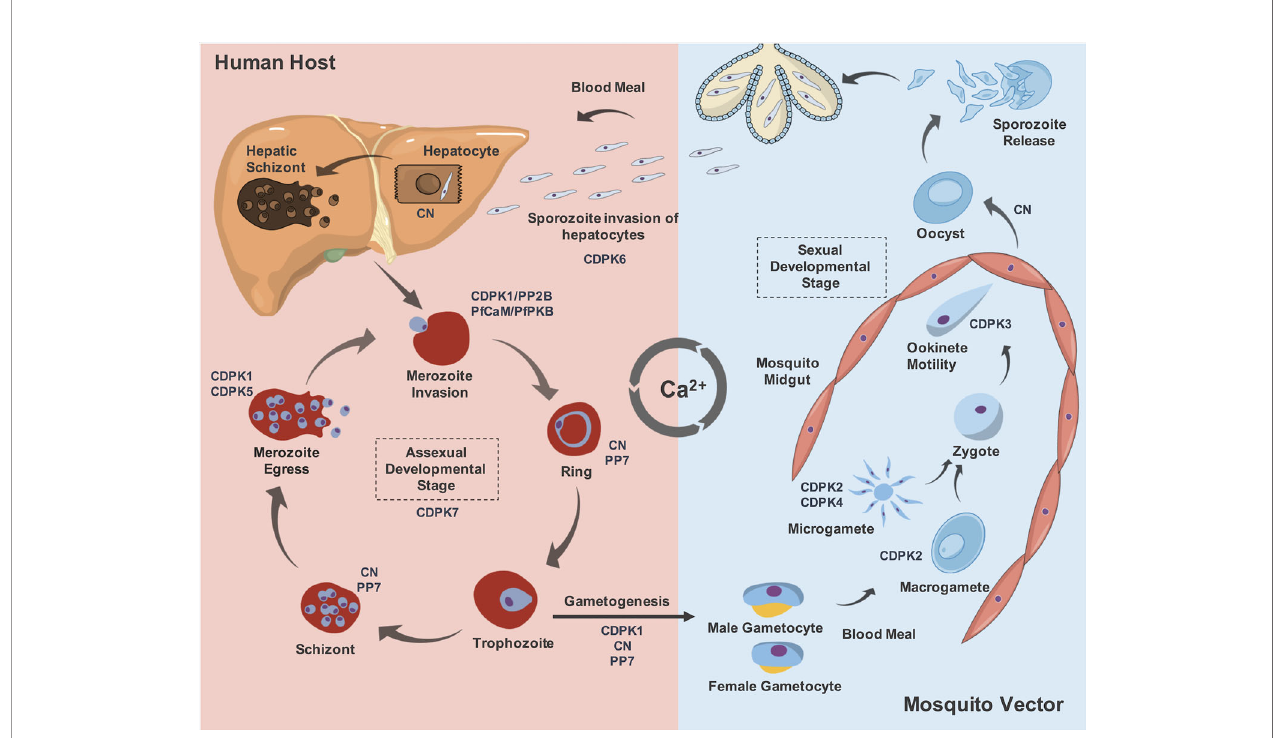
FIGURE 2 | The role of some described Ca 2+ -binding proteins involved in the development stage differentiation and their expression throughout Plasmodium life cycle. During the blood meal, the mosquito vector from genus Anopheles , inoculate sporozoites released from its salivary glands that will invade hepatocytes. This process is described to be CDPK6-dependent. Moreover, CN allows sporozoite-to-liver stages development inside hepatocytes. Following formation of merozoites in the liver cells, they are released in the bloodstream to continue asexual development stages, invading new RBCs. This process is mediated by CDPK1, CN and PfCaM/PfPKB complex. The role of CDPK7 to maintain the asexual developmental stages is also reported. In addition, the presence of the phosphatases CN and PP7 are implicated in the ring and schizont stages. After schizont maturation, the merozoites are released into the bloodstream to invade new RBCs, which mechanism that requires the action of CDPK1 and CDPK5. Some parasites pass through a morphological transition to form gametocytes, and this process depends on CDPK1, CN and PP7. After a blood meal of the mosquito vector, these forms maturate into male ex fl agellated and female gametocytes, named as microgametes and macrogametes, respectively. For this transition, CDPK2 and CDPK4 are required. These forms are fused into a zygote, which maturates to a motile ookinete. The ookinete motility is regulated by CDPK3. The ookinete exits from the lumen of mosquito midgut as an oocyst and this transition is mediated by CN. The maturation of the oocyst will release new sporozoites which will migrate into the salivary glands of the mosquito vector. Thus, in an eventual blood meal, these new sporozoites will infect a new host and complete the parasite life cycle in order to propagate malaria